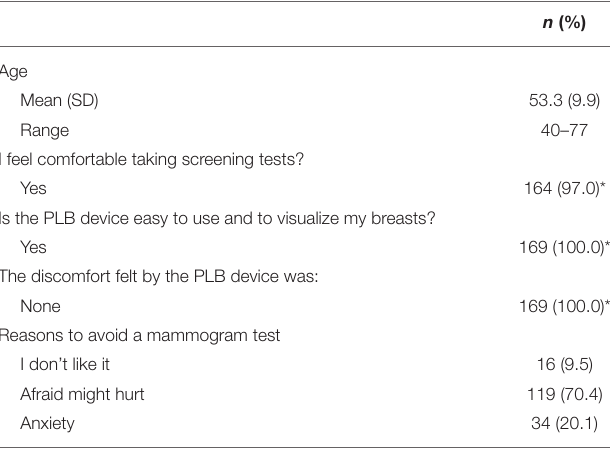
TABLE 3 | Responses for acceptability of breast cancer screening tools and PLB ( n =